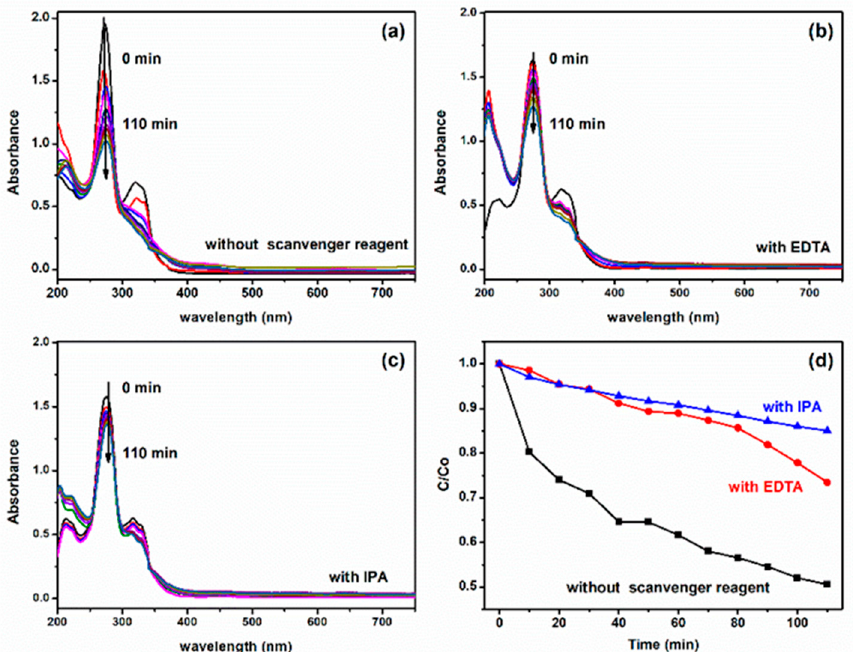
Figure 8. Photocatalytic degradation of CIP in the presence and absence of trapping agents (EDTA and IPA) with BiFe 1 − x Li x O 3 -graphene nanocomposite (x = 0.02). ( a ) Absence of trapping agents, ( b ) with EDTA and ( c ) with IPA, ( d ) C/C o vs. time curves.